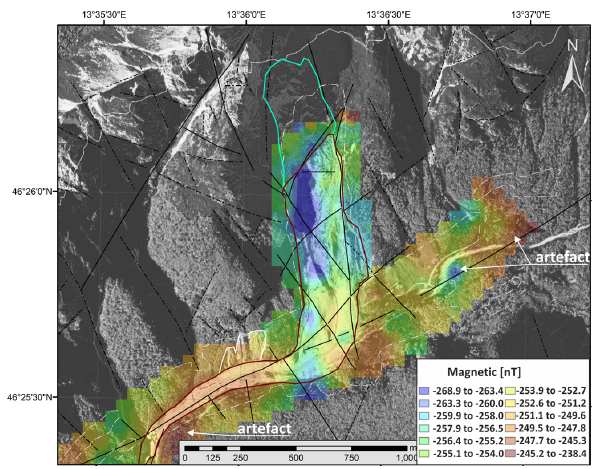
Fig. 5. Map of magnetic anomalies combined with the fault and joint pattern (black full and dot-and-dashed lines), and area of reli- able data (light grey dot-and-dashed line) (Source of data: Geologi- cal Survey of Austria and Google Earth).